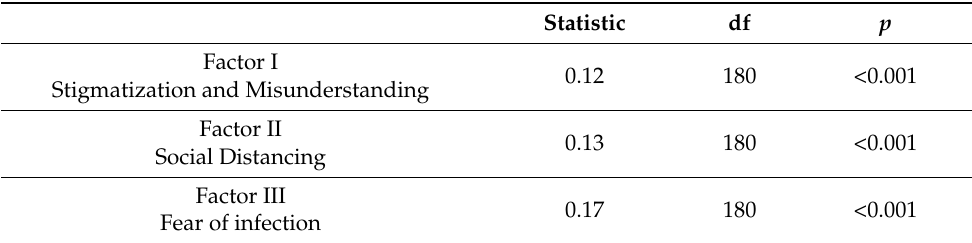
Table 4. Kolmogorov–Smirnov test of normality.